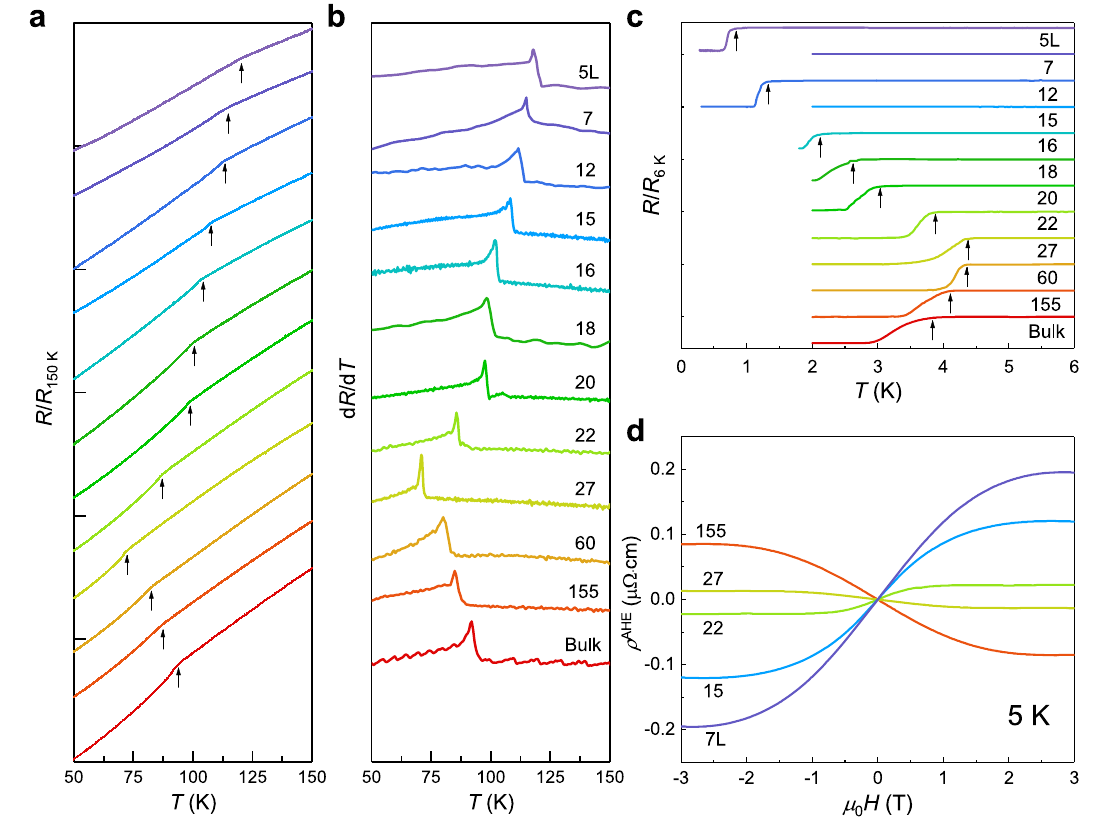
Fig. 2 | Electricaltransport measurementsofCsV 3 Sb 5 thin fl akes. a Evolutionof theCDWkinkwithavariationof fl ake thickness.Allthedataisverticallyshifted for clarity. The transition temperatures T CDW are determined from the kink in the R – T curve,whichgivesconsistentresultsbytakingthe fi rstderivatived R /d T asshownin